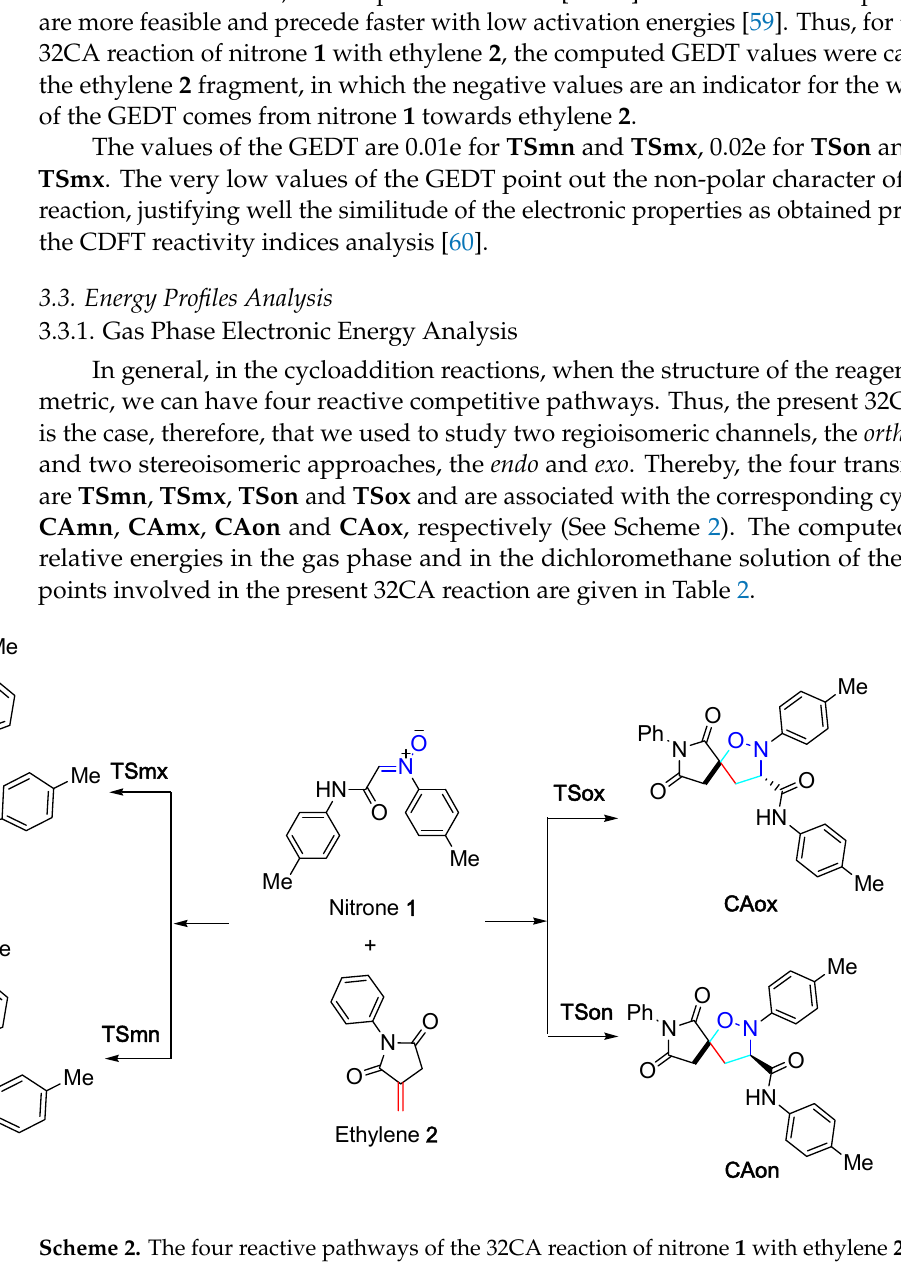
Table 2. Values of total and relative energy in gas phase and in dichloromethane solution of sta ‐ tionery points of the32CA reaction between nitrone 1 and ethylene 2. E (a.u) Δ E (kcal/mol) E (a.u) Δ E (kcal/mol) System Gas Phase Dichloromethane Alkene −